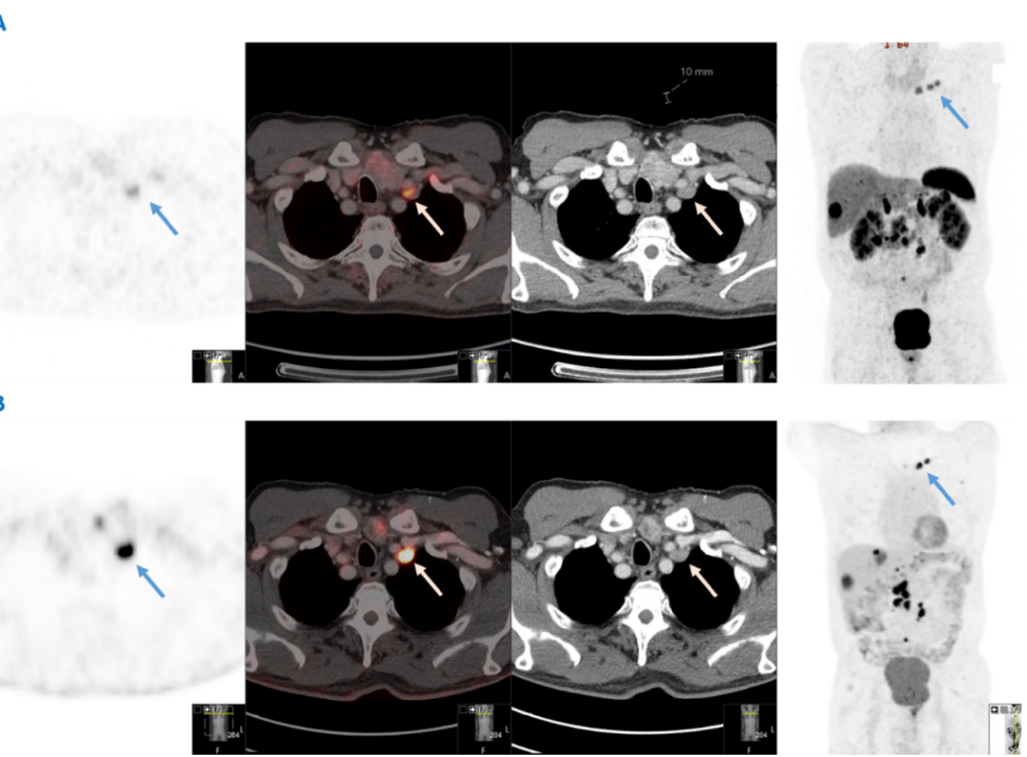
Figure 1. Dual functional imaging of a patient with a G2 small intestinal neuroendocrine neoplasm and Virchow’s node metastases (blue and white arrows), both 68 Ga-DOTATATE- and 18 F-FDG avid. ( A ) From left to right: 68 Ga-DOTATATE PET; fusion; computed tomography; and maximum intensity projection (MIP) images ( B ) From left to right: 18 F-FDG PET; fusion; computed tomography; and maximum intensity projection (MIP) images.